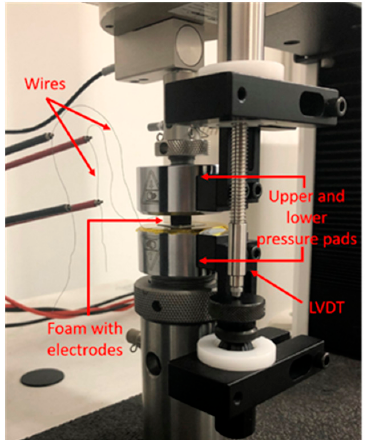
Figure 8. Image of the electromechanical setup.